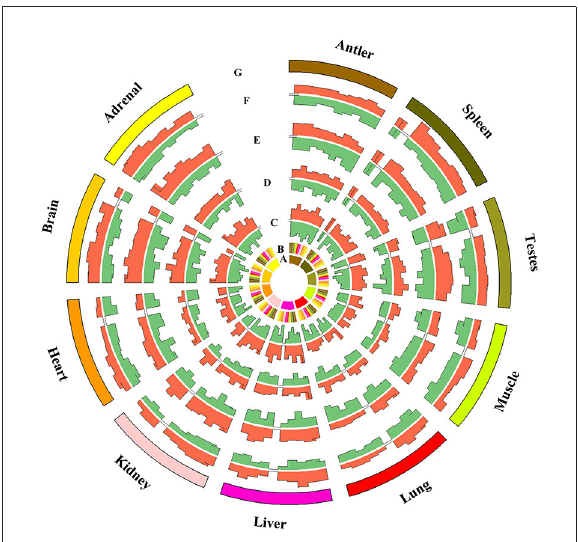
FIGURE3 Comparison of miRNAs differentially expressed between any two tissues at the same stage (fold change ≥ 2 or ≤ 0.5, q value ≤